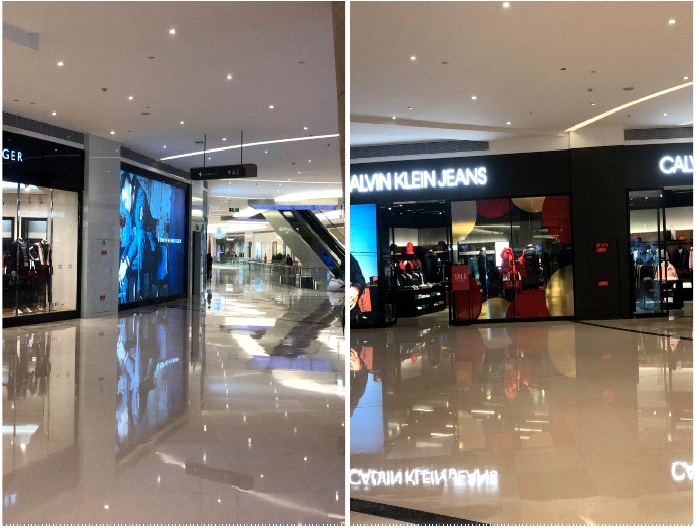
Figure 6. Indoor environment.